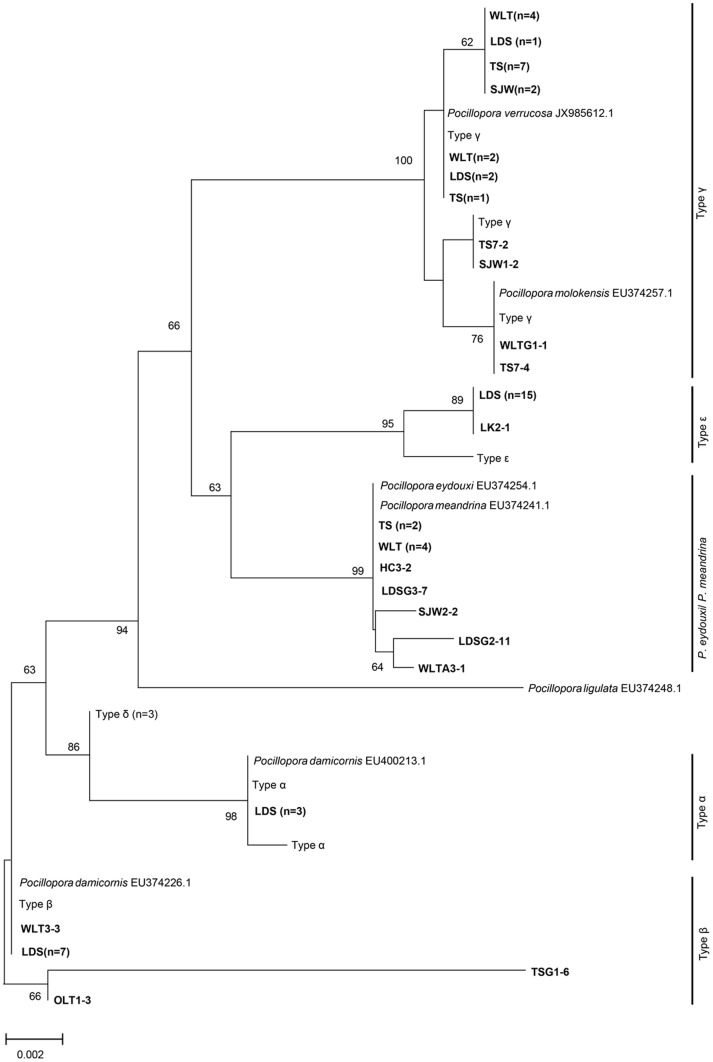
NJ tree of the mitochondrial ORF sequence of Pocillopora.Neighbor-joining tree of ORF sequence constructed by Tamura 92 model with sequences from [51] and [53] (personal communication). Samples from different sites and numbers in parentheses labeled in bold were discovered from the settlement plate in this study. There are four mitochondrial haplotypes (alpha, beta, gamma, and epsilon) found in P. damicornis.